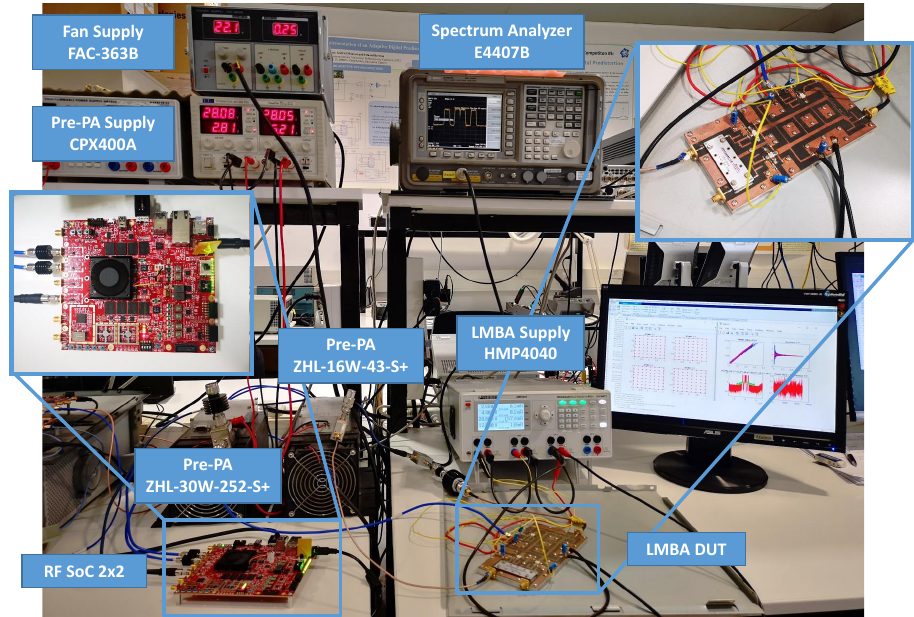
Figure 4. Picture of the experimental test-bed. The device under test consists in a load modulated- balanced amplifier